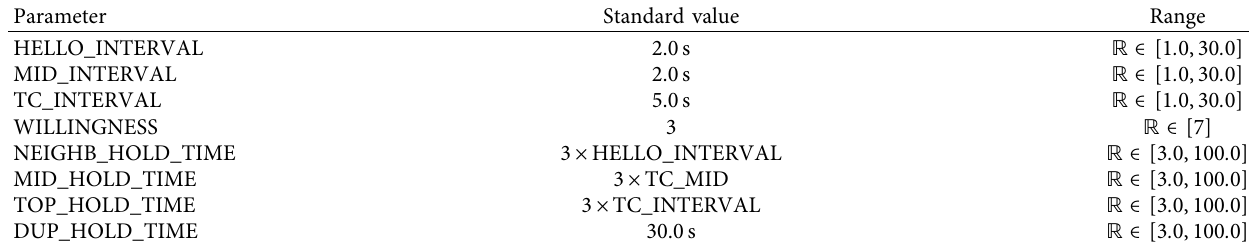
Table 2: Predefined OLSR parameters